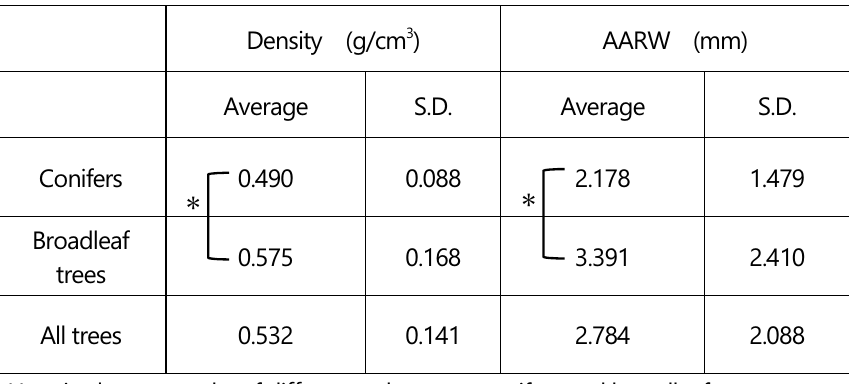
Table 2 Average values of density and AARW in Table